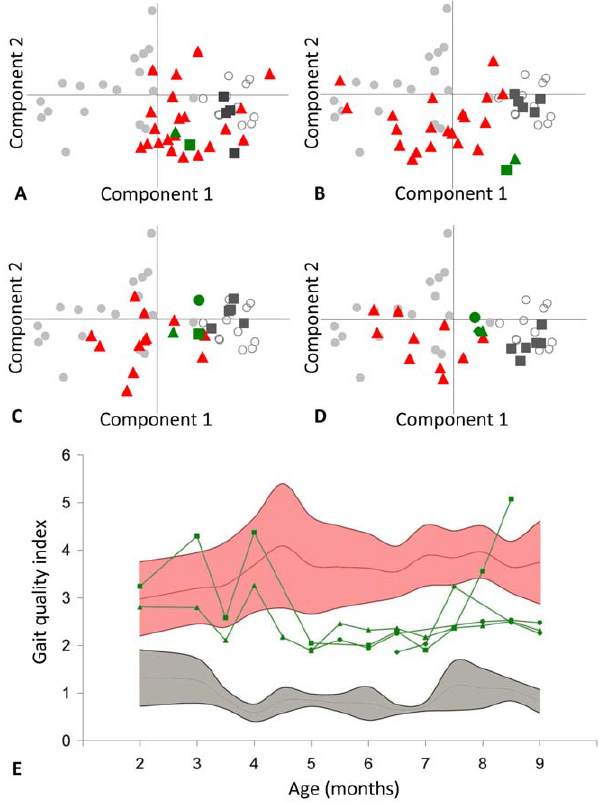
Figure 6. Gait evaluation during the treatment: global analysis by the study of the dog’s course on the reference PCA plane quantified by the gait quality index. Position of the treated dogs (green own symbols) on the reference PCA plane defined by 18 adult GRMD dogs (grey circles) and 11 adult healthy dogs (empty circles), at 2 (A), 4 (B), 6 (C) and 9 (D) months. The age-matched untreated GRMD dogs are represented by red triangles and the age-matched healthy dogs by dark grey squares. The PCA was performed using 7 variables (stride frequency, stride length, total power, 3 relative axial powers, regularity), and the 2D-representation of the PCA induces a very low information loss, because it represents 90.58% of the variance (component 1: 68.17%, component 2: 22.41%). It is remarkable that the treated GRMD dogs, initially matched in position with untreated GRMD dogs, progressively move towards an intermediary position between GRMD and healthy dogs. This is quantitatively supported by the evolution of the gait quality index (graph E). The individual evolutions in treated dogs (green curves) are compared to the mean (red curve) 6 SD (pink area) of untreated GRMD dogs and the mean (grey line) 6 SD (grey area) of healthy dogs, in function of the age. The gait quality index is, from the age of 5 months in treated dogs, within intermediary values between untreated GRMD and healthy dogs. The position of the treated dogs is significantly nearer from the healthy center of gravity between 5 and 9 months.